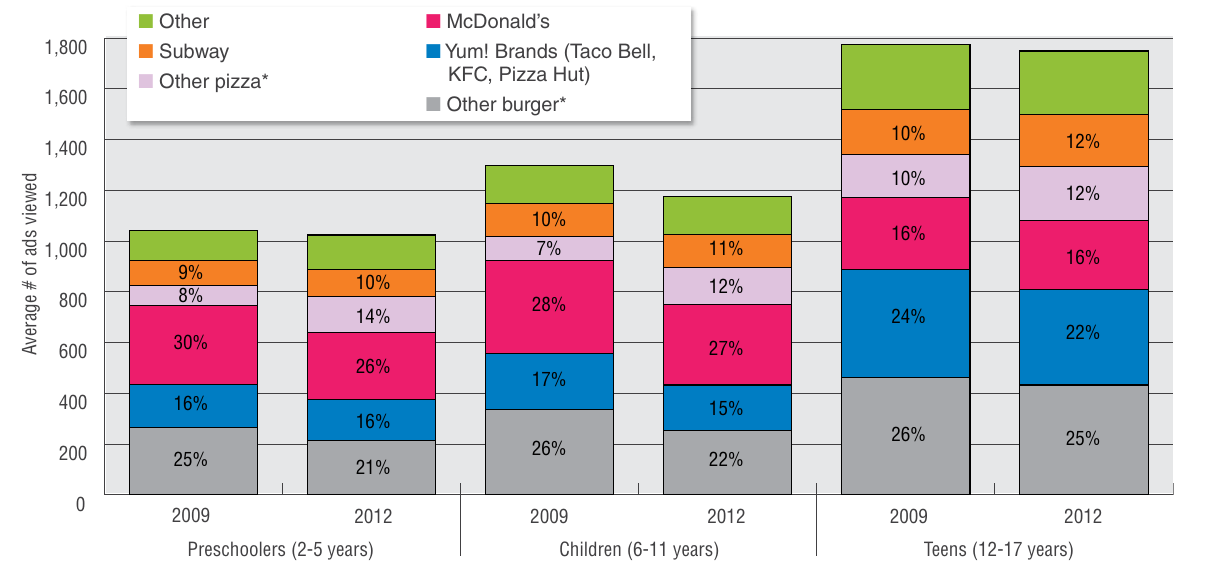
Figure 8. TV advertising exposure by restaurant and age